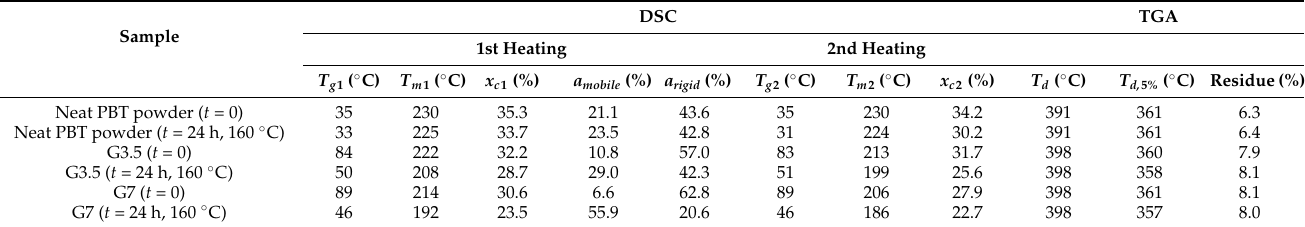
Table 2. Thermal properties of the neat PBT powder, physical mixtures (G3.5, G7) and the relevant alcoholysis products ( t = 24 h, 160 ◦ C).